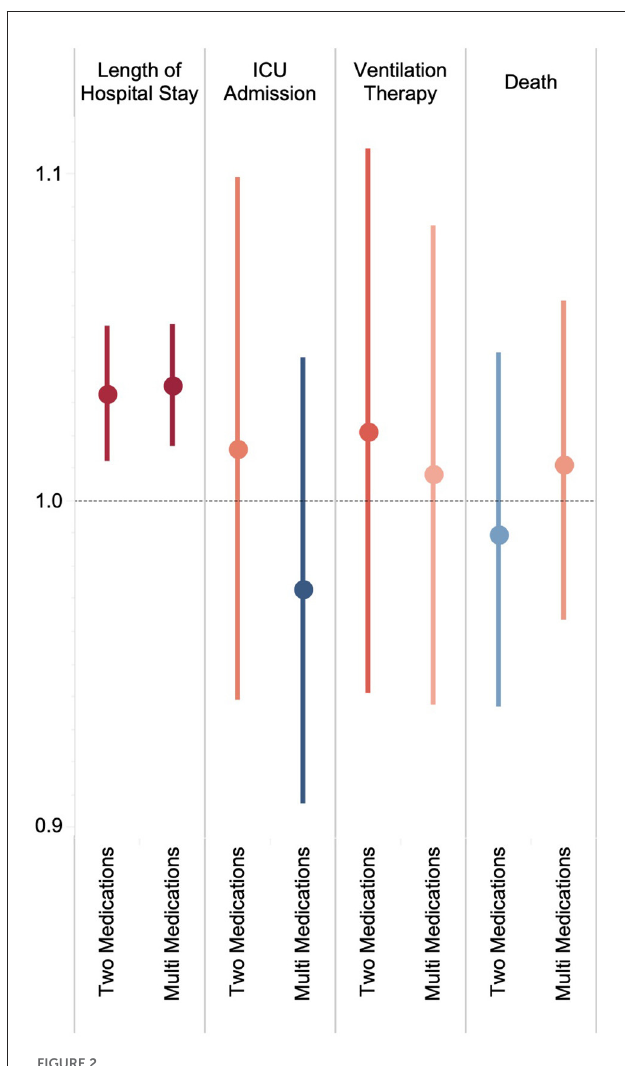
FIGURE2 Change in length of hospital stay and ORs of ICU admission, ventilation therapy, and death by the number of chronically used medications.